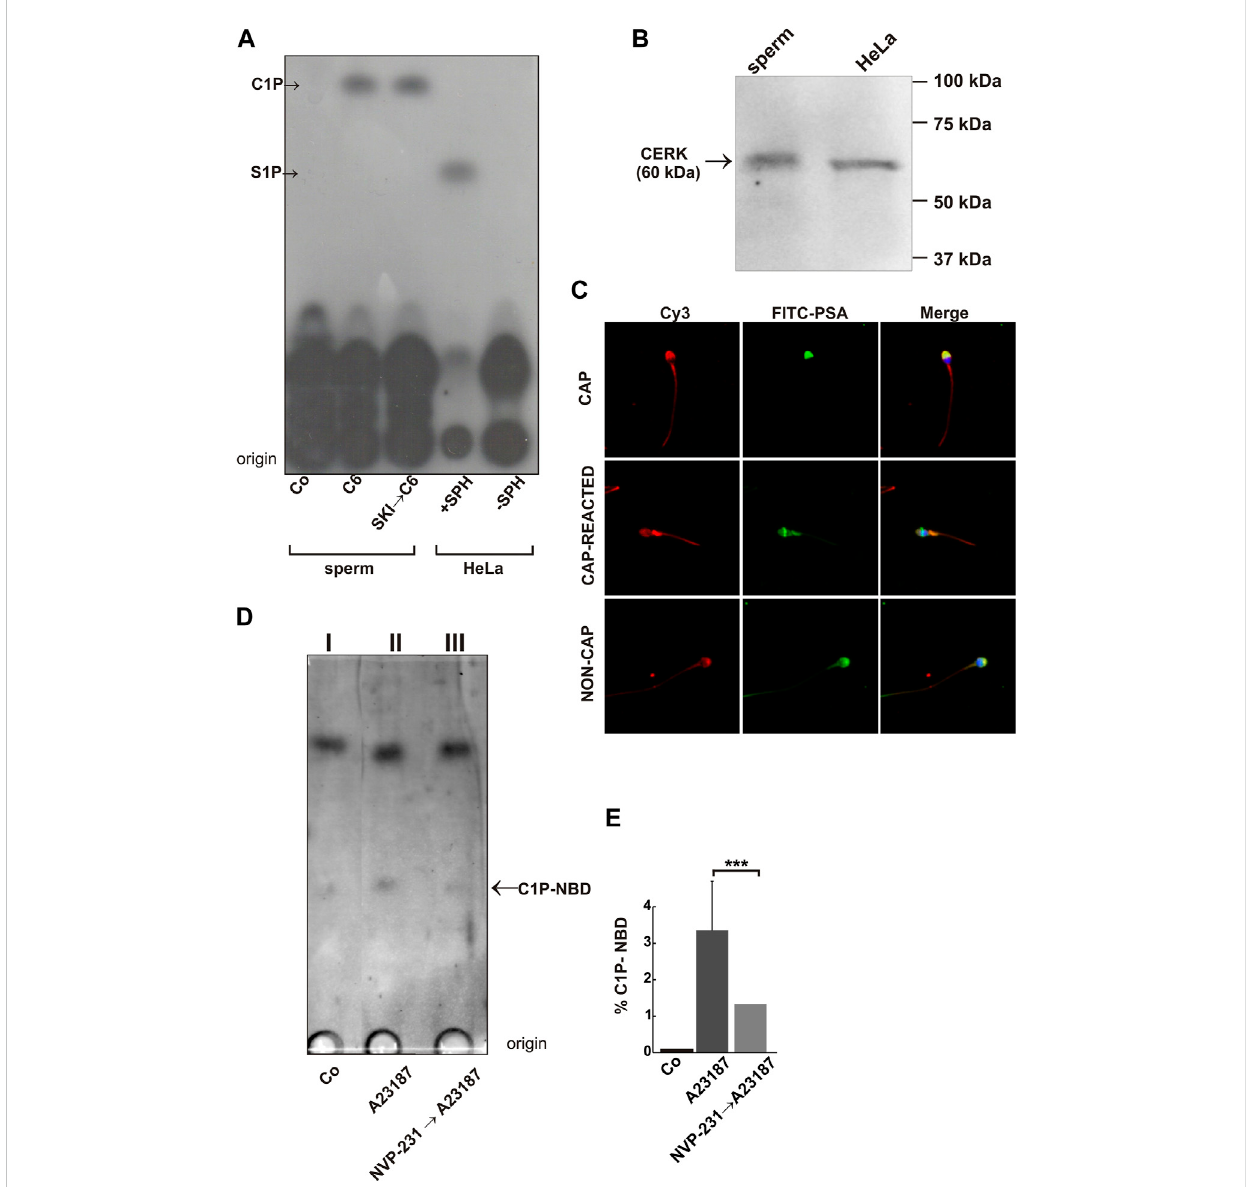
FIGURE 4 C6-Ceramide induces C1P synthesis in human spermatozoa. (A) After swim-up in HTF at 37 ° C, 5% CO 2 , sperm were incubated under capacitating conditions for 2 h, and permeabilized with streptolysin O as described in our previous publications (Lopez et al., 2012; Pelletan et al., 2015). When indicated, we incubated permeabilized sperm in SK1 buffer containing 1 μ M SKI (speci fi c Sphingosine Kinase Inhibitor) for 15 min at 37 ° C. We further incubated the samples for 15 min at 37 ° C with 50 μ M fatty acid free bovine serum albumin-sphingosine, 1 μ L of [ γ - 32 P]ATP in the absence of any stimulus (Control, Co) or 10 μ M C6-Cer (C6, SKI → C6). HeLa cells (positive control, incubated with sphingosine; +SPH, and negative control with no sphingosine added; -SPH) were prepared as described under “ Materials and Methods ” . Thin-layer chromatograms were developed in 1-butanol/ methanol/acetic acid/water (8:2:1:2, v/v) and observed by autoradiography. The fi gure is representative of three experiments. (B) CerK is present and catalyzes C1P synthesis in response to calcium increase in human spermatozoa. Sperm proteinswere extracted in Laemmli sample buffer (10 × 10 6 cells) and analyzed by Western blot with a rabbit polyclonal anti-CERK antibody (sperm). HeLa extract (HeLa) was used as a control. (C) Capacitated (CAP) and non-capacitated (NON-CAP) human sperm were fi xed and double-stained with an anti-CERK antibody followed by an anti-rabbit Cy3 (red: Cy3) and FITC-PSA to differentiate between reacted and intact sperm (green: FITC-PSA). The middle panel shows a capacitated cell that in response to the Pg stimulilostitsacrosome(CAP-REACTED)andCy3stainingremainsdiffuse.Mergedimagesareshown(stainedspermnucleiarevisualizedinblue,Merge). (D) Capacitated sperm were loaded with a fl uorescent ceramide (4-nitrobenzo-2-oxa-1,3-diazole – labeled C12-ceramide, NBD-ceramide). After that, cells were incubated or not (Co, basal activity) with a calcium ionophore, A23187, to increase the [Ca 2+ ]i. One batch of ionophore-treated cells was previously incubated with the CERK inhibitor, NVP-231 (adamantane-1-carboxylic acid (2-benzoylamino-benzothiazol-6-yl)amide) 200 nM. Before resolving ceramide metabolites by TLC, we separated them according to their lipophilicity as described in “ Materials and Methods ” . (E) . Quanti fi cation of spot intensity of three thin-layer chromatograms corresponding to C1P-NBD. A signi fi cant increase of C1P-NBD was assessed by t -test for single group mean signi fi cant (***, p ≤